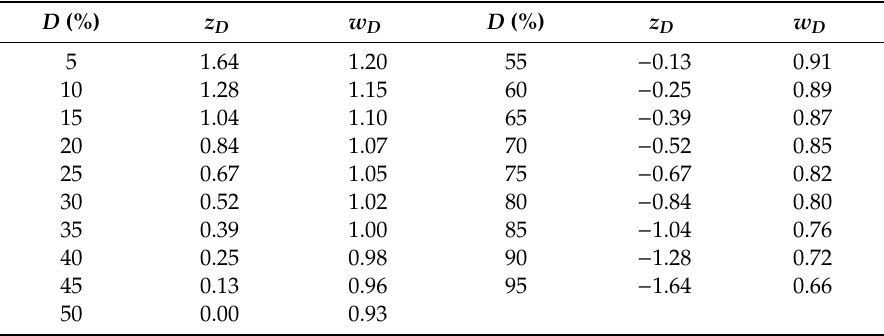
Figure 5. The P–P plot of the dimensionless monthly streamflow data after normalization. Table 7. Calculation of normal quantiles.